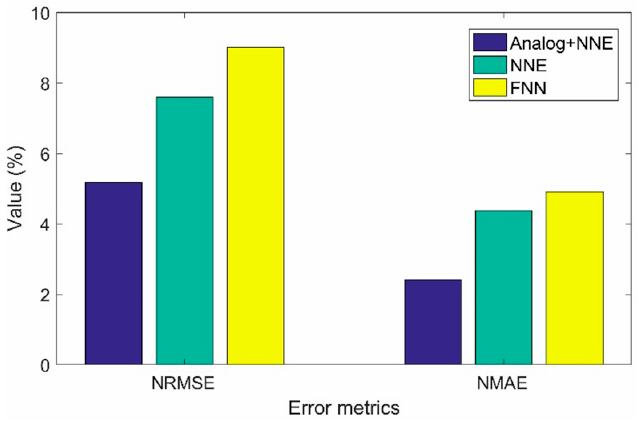
Figure 9. Error metrics comparison of the methods.